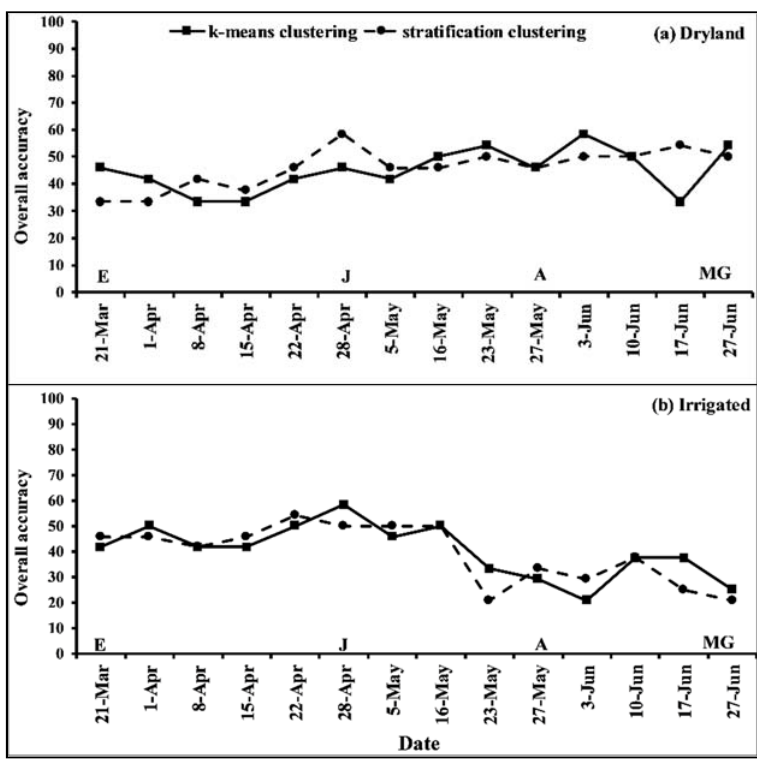
Figure 7. Overall accuracy results from contingency table comparing mean grain yield classes to mean NDVI classes using k-means clustering (solid line with squares) and stratification clustering (dashed line with circles). The overall accuracy is presented across 14 dates for site year II under ( a ) dryland conditions and ( b ) irrigated conditions. Critical growth stages are indicated as A = anthesis growth stage, E = early spring growth stage, J = jointing growth stage, and MG = mid-grain filling growth stage.